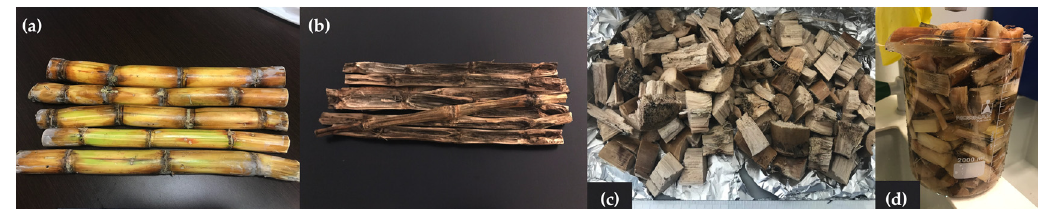
Figure 2. Sequence of procedures to obtain sugarcane pieces used in torrefaction tests: ( a ) raw material as bought; ( b ) sugarcane after being processed with the roller mill; ( c ) sugarcane pieces; and ( d ) pieces being washed.